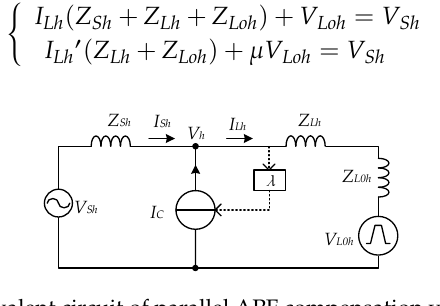
Figure 6. Single-phase equivalent circuit of parallel APF compensation voltage source type nonlinear load under a distorted system voltage.